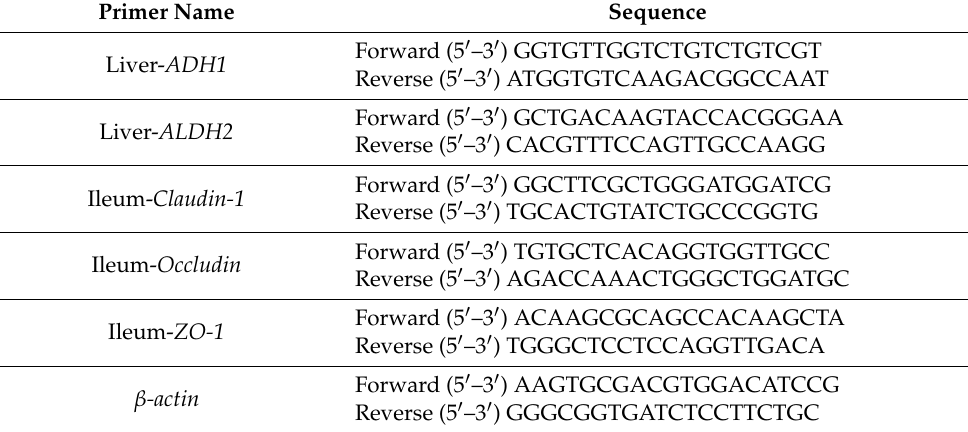
Table 2. The sequences of the gene